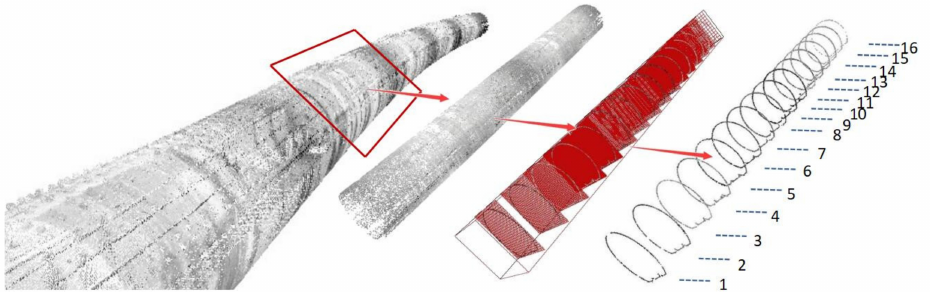
Figure 11. Cross-section generation.